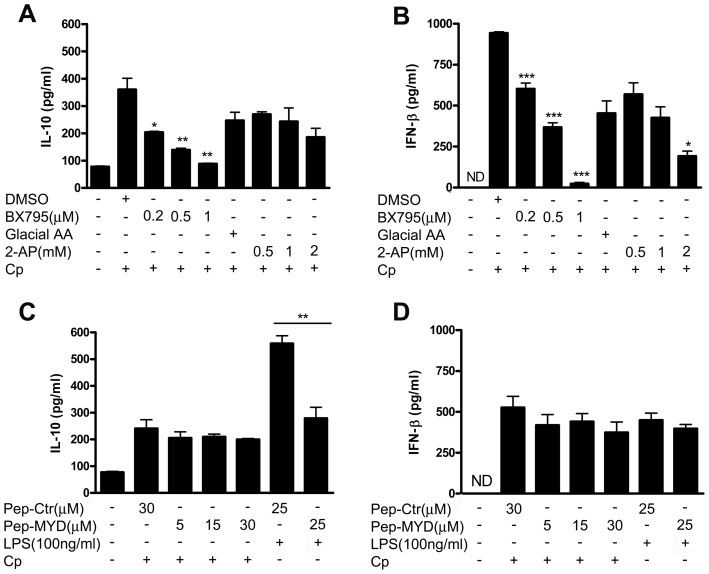

C. pneumoniae induces IFN-β and IL-10 production in BMDM from B6.C3H-sst1 via TBK1/IKKξ dependent pathway and is independent of MyD88.BMDM were prepared from B6.C3H-sst1 mice as described in the Methods. Prior to infection with C. pneumoniae (Cp) or treatment with LPS, cells were pretreated with IFN-γ (5 U/ml) and the following inhibitors for 30 min at the indicated concentrations; supernatant was harvested at 24 hpi for assay of IL-10 and IFN-β. A–B: TBK1/IKKξ inhibitor BX795 or vehicle control (DMSO); or the PKR inhibitor 2-aminopurine (2-AP) or vehicle control PBS∶Glacial acetic acid at a ratio of 200∶1 (Glacial AA). C–D: MYD88 inhibitor Pepinh-MYD (Pep-MYD), or Pepinh-control (Pep-Ctr) Significance: *, p≤0.05; **, p≤0.01; ***, p≤0.001 compared to corresponding control. The results are representative of 2 independent experiments.